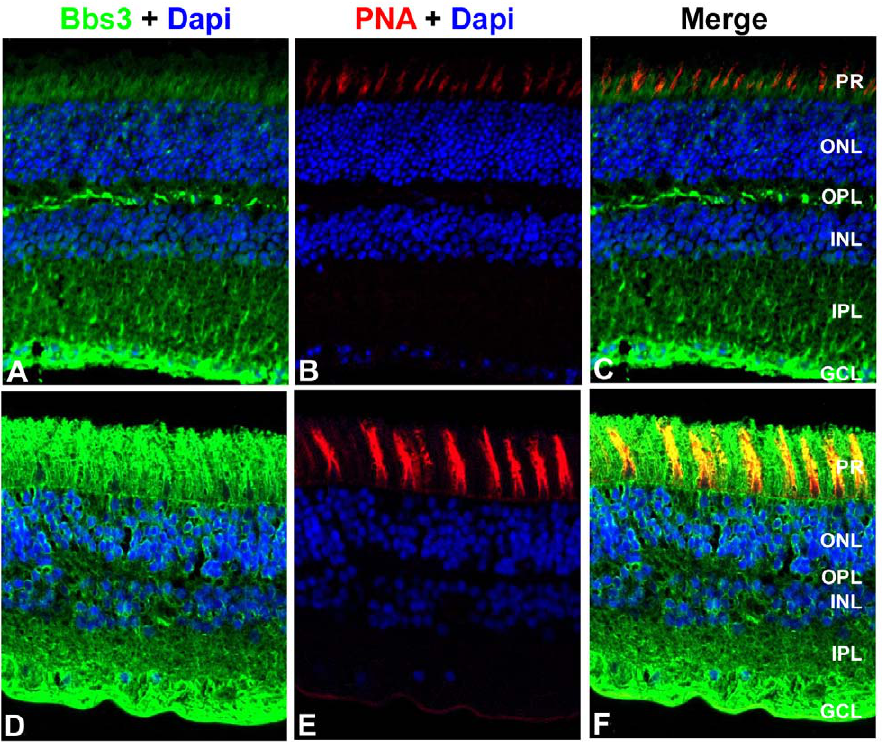
Figure 5. Localization of BBS3 in human and wild-type mouse retinas. Immunohistochemistry triple labeling of cryosections taken from 8- month old wild-type mouse retinas (A–C) and human donor eyes (D–F). Localization of BBS3 (green) using an antibody generated against a central region of the mouse Bbs3 peptide, which recognizes both Bbs3 and Bbs3L (A,D). Peanut agglutinin (PNA, red) was used as a marker for cone outer segments (B,E). Nuclei were counterstained with DAPI (blue). Bbs3 was found robustly in the ganglion cell layer as well as the photoreceptor cell layer of human and mouse retinas. PR, photoreceptor; ONL, outer nuclear layer; OPL, outer plexiform layer; INL, inner nuclear layer; IPL, inner plexiform layer; GCL, ganglion cell